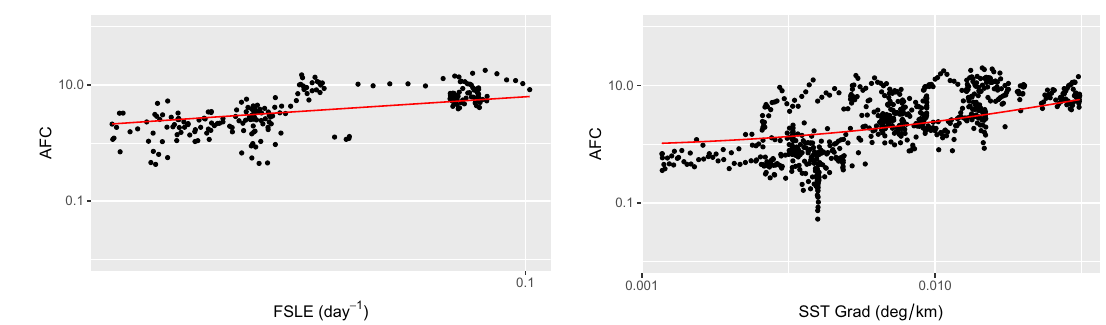
Figure 4. Left panel: scatter plot of AFC against FSLE (left panel) for the sub-set of points whose local chlorophyll concentration is higher than 0.22 mg/m 3 . Right panel: scatter plot of AFC against SST gradient (right panel) for the sub-set of points whose local chlorophyll concentration is higher than 0.17 mg/m 3 . For both panels, the red line is obtained from the respective linear interpolation of the selected points (note that axes are reported in logarithmic scale). Left panel: R = 0.66, R 2 = 0.43, p < 0.001. Right panel: R = 0.54, R 2 = 0.29, p < 0.001. Sensitivity of the results with respect to the chlorophyll threshold chosen is reported in